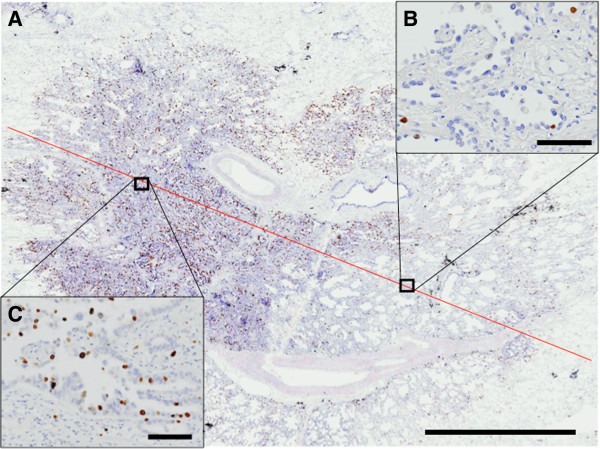
Reflection of tissue heterogeneity by Spiral Array. A) Ki-67 immunohistochemical staining of lung adenocarcinoma shows variable amounts of positive cells within the slide. Red line indicates the area of coverage inside the Spiral Array (bar = 5 mm). Both high expression area of Ki-67 (B) and low expression area of Ki-67 (C) are included inside the same reel of Spiral Array.